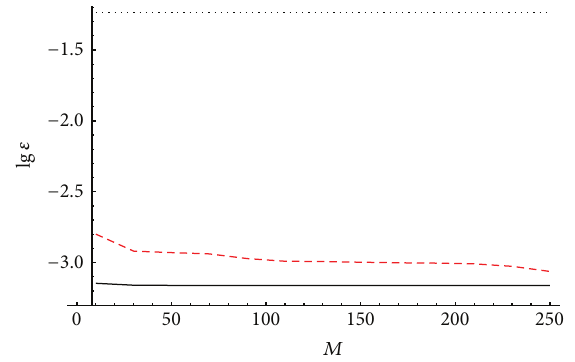
Figure 5: The relative error of reconstruction of refractive index for the parabolic layer versus the number of iterations 𝑀 . Refractive index is discontinuous on the layer boundaries. The solid curve cor- responds to reconstructing frequencies 20–22 THz, the red dashed curve corresponds to reconstructing frequencies 42–44 THz, and the dotted curve corresponds to reconstructing frequencies 61– 63